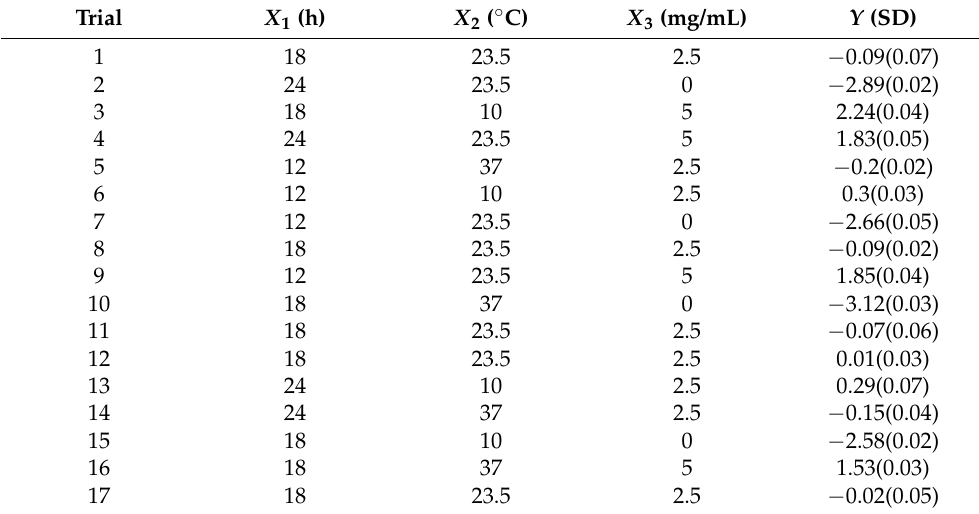
Table 2. The design and response of the Box–Behnken experiment of CA against the growth of E. Sakazakii